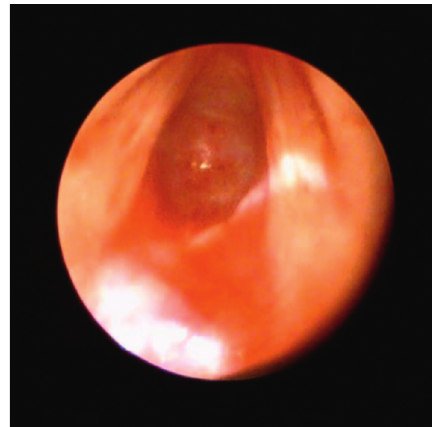
Figure 2: Rigid laryngoscopy of vocal cords and subglottis. The petechiae present on the distal wall of the blind-ended laryngeal pouch from previous intubation attempts are noted. No tracheal rings are